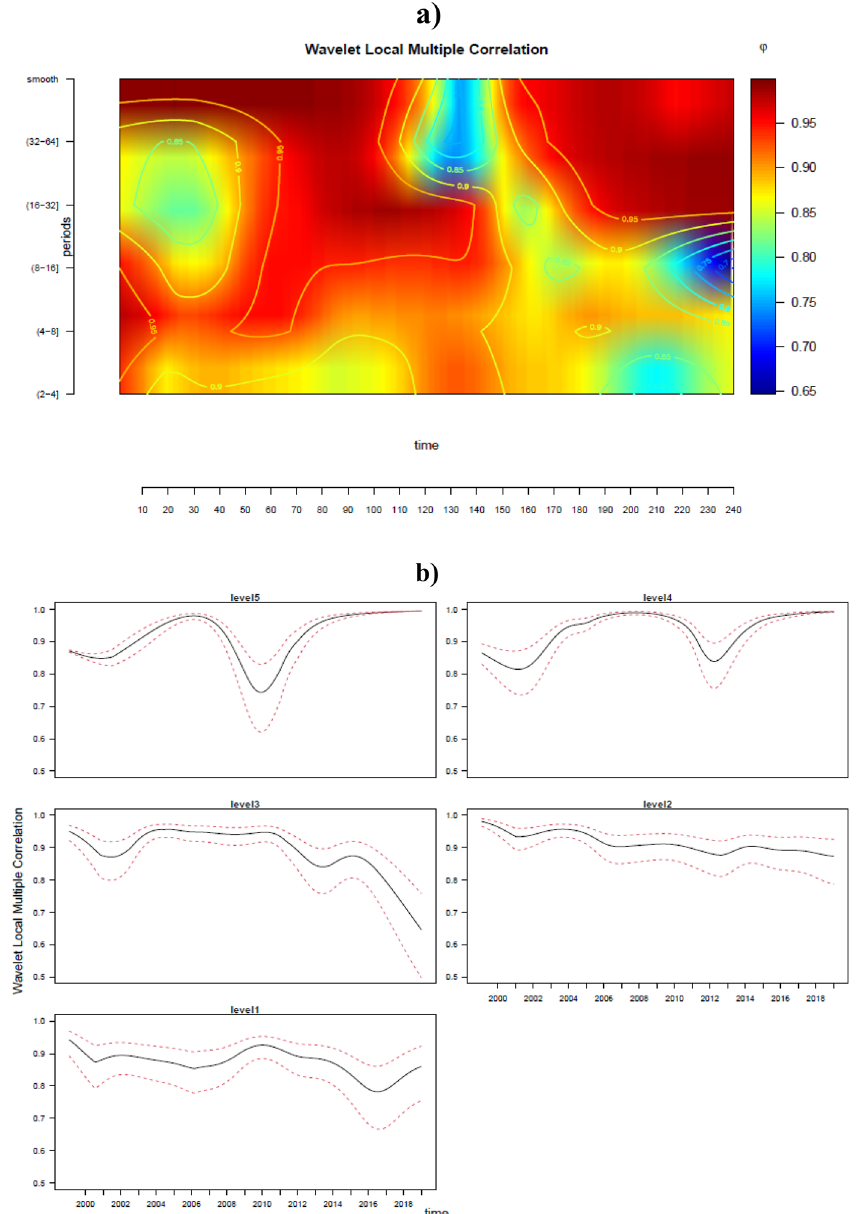
Fig. 6 Wavelet Local Multiple Correlation for log first difference of the dinar (DZD/SDR), dollar (USD/SDR) and Euro (EURO/SDR) against the special drawing rights. “Level 1”, “Level 2”, “Level 3”, “Level 4” and “Level 5” represent five different wavelet scales that capture dynamics with five different periods in the range of 2–4, 4–8, 8–16, 16–32 and 32–64 months, respectively. The red lines correspond to the upper and lower bounds of the 95% confidence